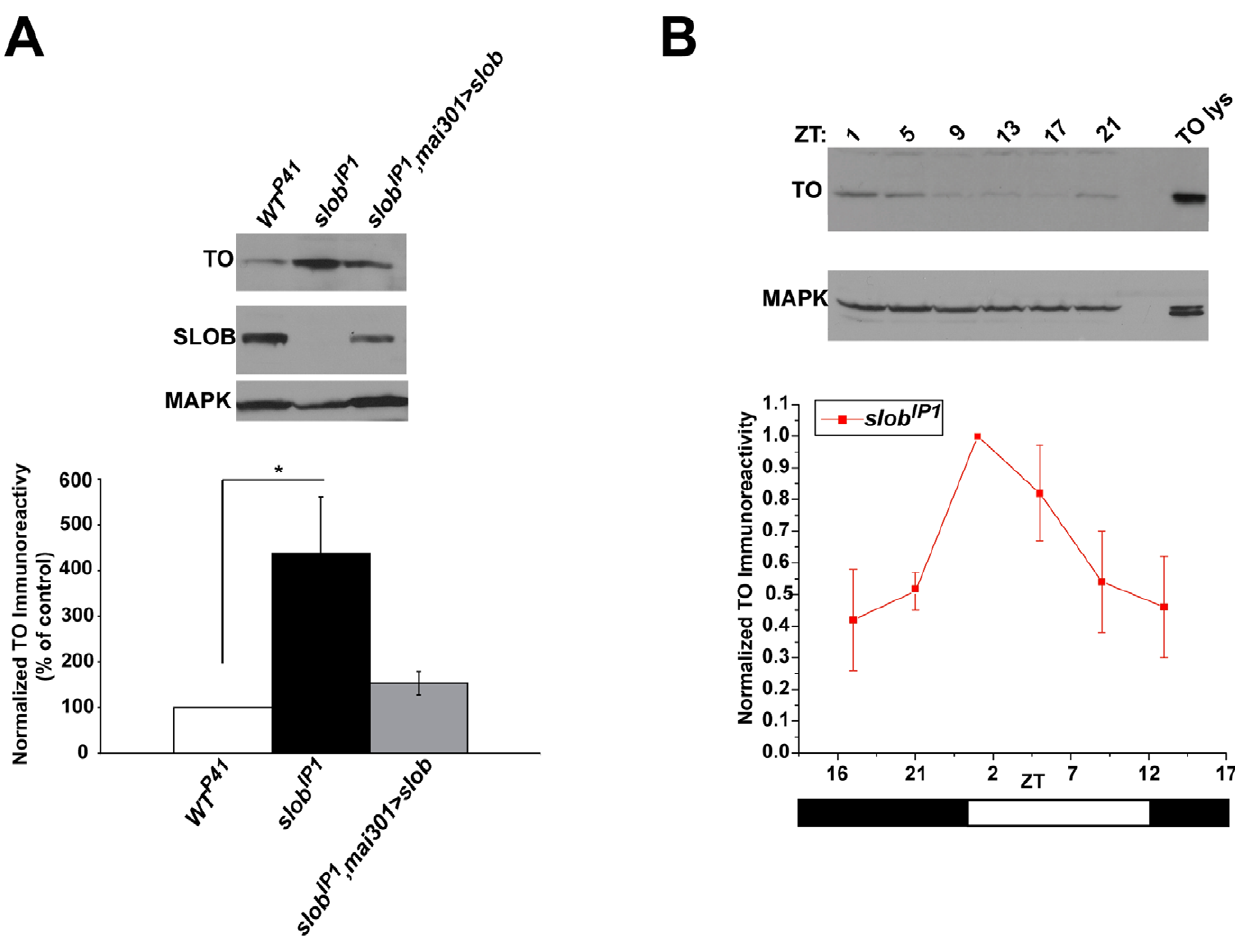
Figure 2. TO protein levels are increased in slob IP1 fly heads but still cycle. TO protein levels in fly heads were measured by Western blot analysis and normalized to MAPK levels. A , Representative Western blot showing an increase in TO expression in slob IP1 fly heads compared to WT P41 fly heads. TO levels are rescued in slob IP1 ,mai301 . slob fly heads. The graph is a summary of four independent experiments (mean 6 SEM). * indicates p , 0.05, One-way ANOVA with Bonferroni post-test. B , Representative Western blot showing that TO levels cycle in slob IP1 fly heads. Zeitgeber time (ZT) is plotted on the X axis; the white and black bars represent ‘‘lights on’’ and ‘‘lights off’’, respectively. The graph is a summary of three independent experiments (mean 6 SEM).